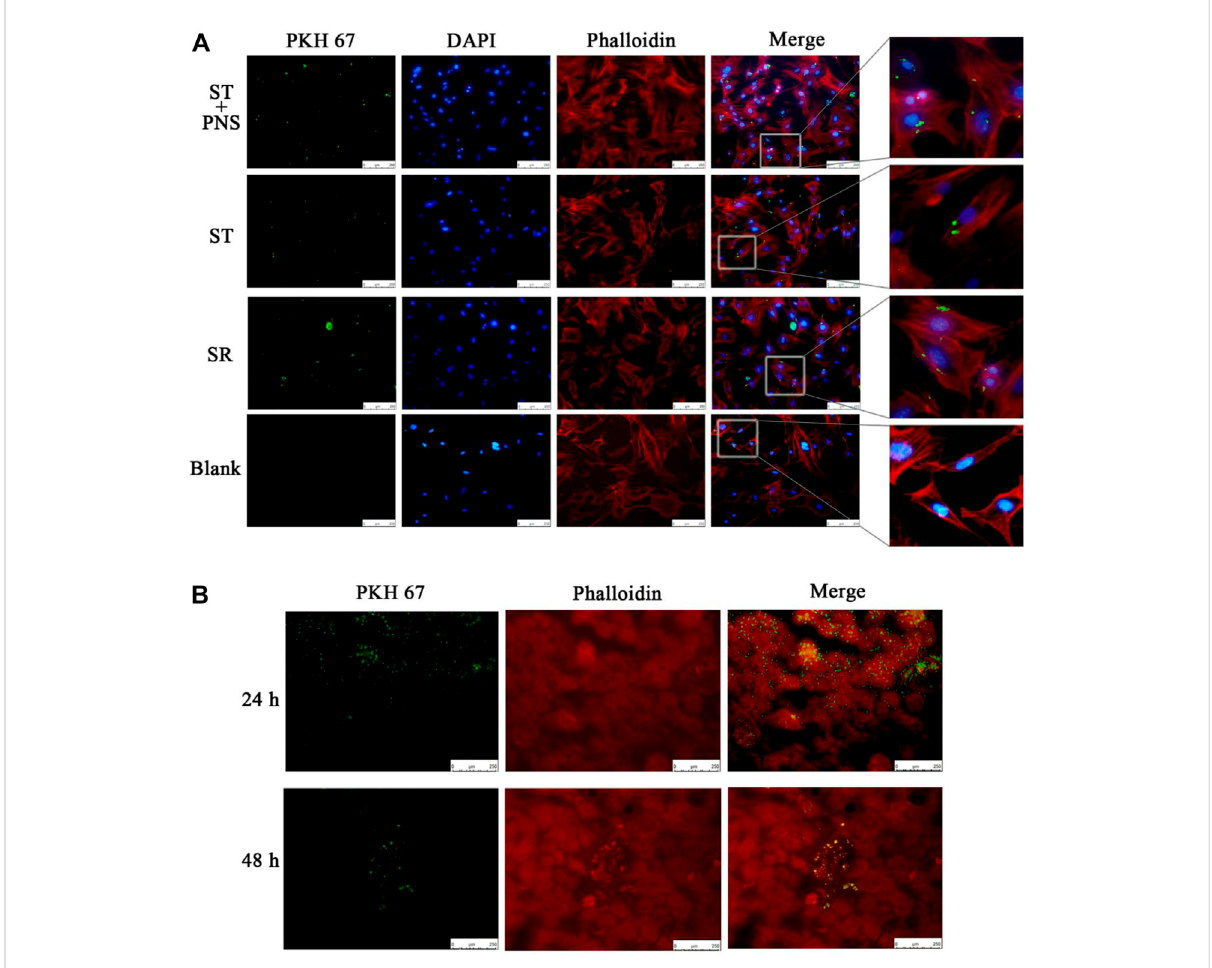
FIGURE 2 Levels of exosome uptake by kidney. (A) Uptake of PKH67-labeled exosomes (green fl uorescence) by GECs (red and blue fl uorescence, phalloidin and DIPA-stained cytoskeleton) in each group by cellular immuno fl uorescent staining. A blank control group was set up in parallel (scale bar250 μ m;enlargedimage). (B) AftertheinjectionofPKH67-labeledexosomesintothetailvein,themiceweresacri fi cedat24and48 h.Thekidney cortexwastakenforfrozensectioning.TheuptakeofPKH67-labeledexosomes(ultracentrifugationtoremoveexcessdye)wasobservedinthe kidney (scale bar 250 μ